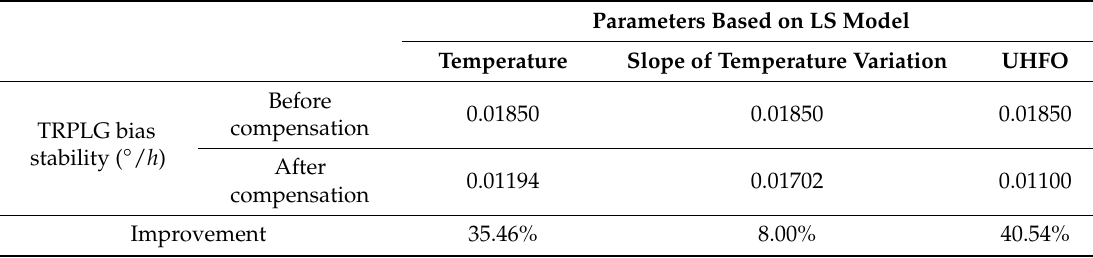
regression; ( b ) Results after compensation.